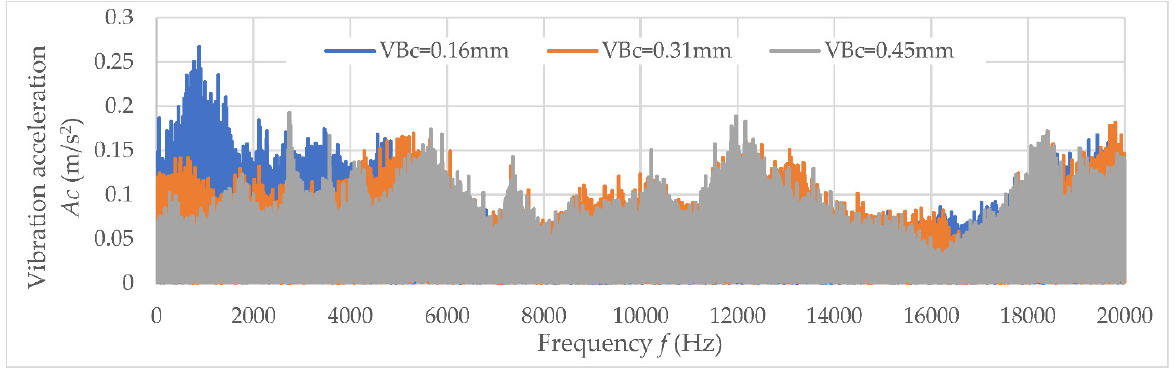
Figure 9. The amplitude-frequency characteristics for main analyzed direction Ac.